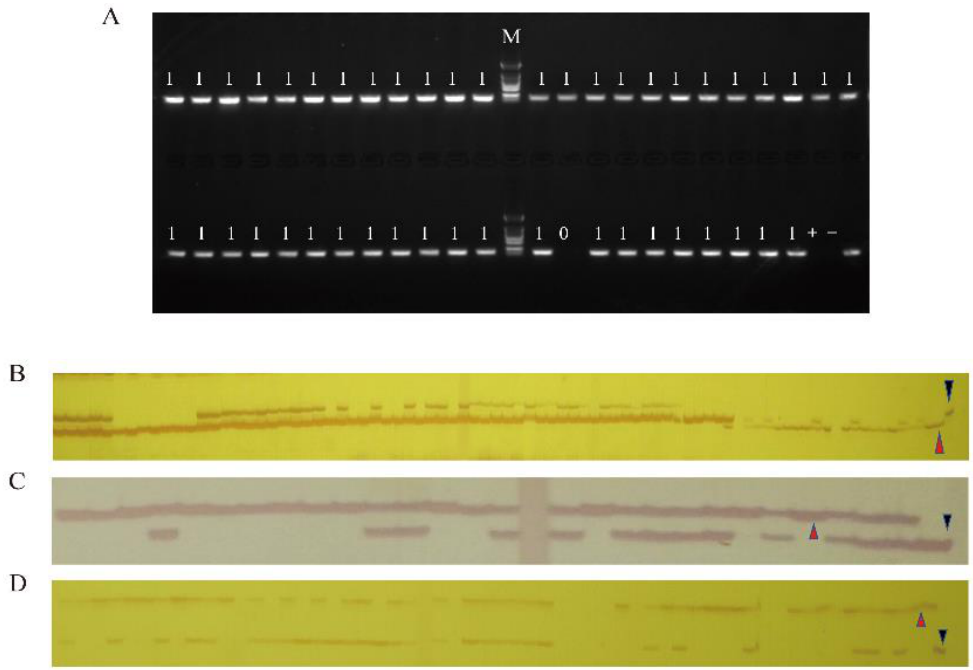
Figure 1. Identification results of prospect selection in the BC 1 population. The images show the identification results of the four markers. ( A ) Polymorphism detection of marker BnRFO-AS2, 0: No specific band has been amplified; 1: Specific band has been amplified; M: Marker. ( B ) Polymorphism detection of marker cnu_m090a. ( C ) Polymorphism detection of marker A08-300. ( D ) Polymorphism detection of marker Sau_um353. Red triangles represent R2163 without resistance and blue triangles represent Huashuang 5R with resistance.